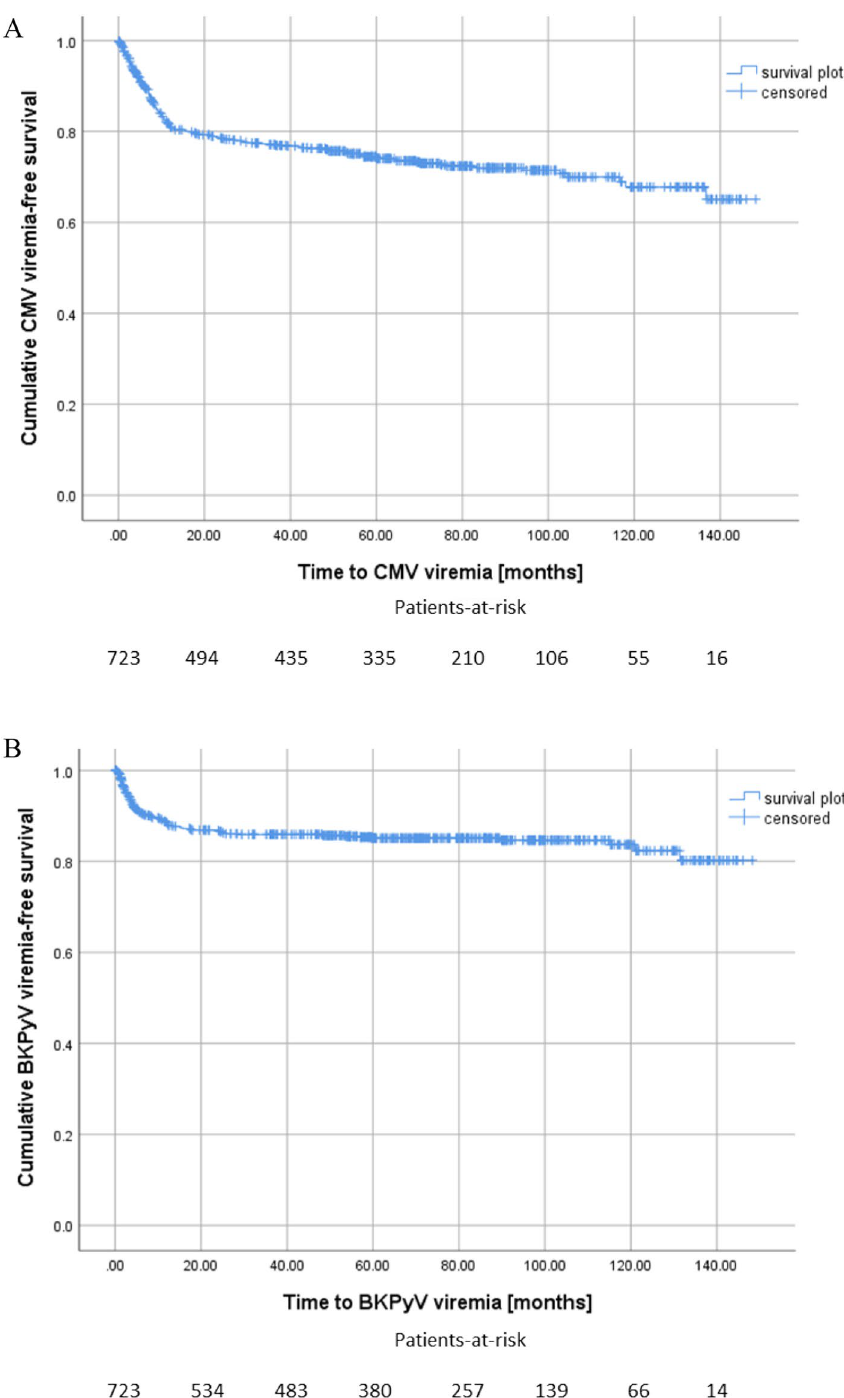
Figure 2. Kaplan Meier survival plots for onset of CMV viremia, median: 7.7 months. ( A ), BKPyV viremia, median: 4.0 months ( B ) and co-infection, median: 3.6 months ( C ) after kidney